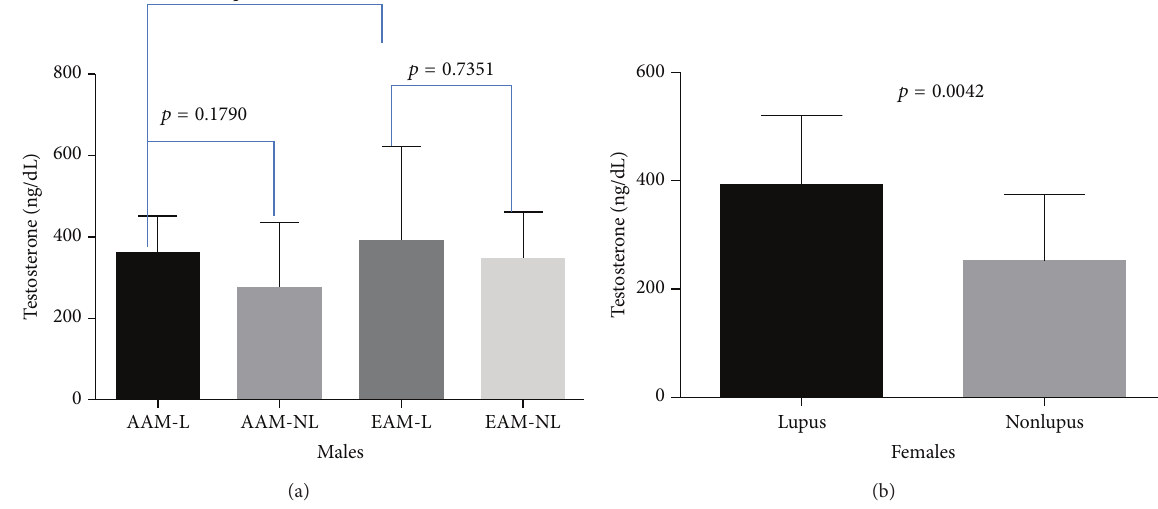
Figure 10: Testosterone levels in serum. (a) No difference was found in testosterone between the small numbers of males with lupus in this study; however, we did notice a higher level of testosterone in a small number of women less than fifty years of